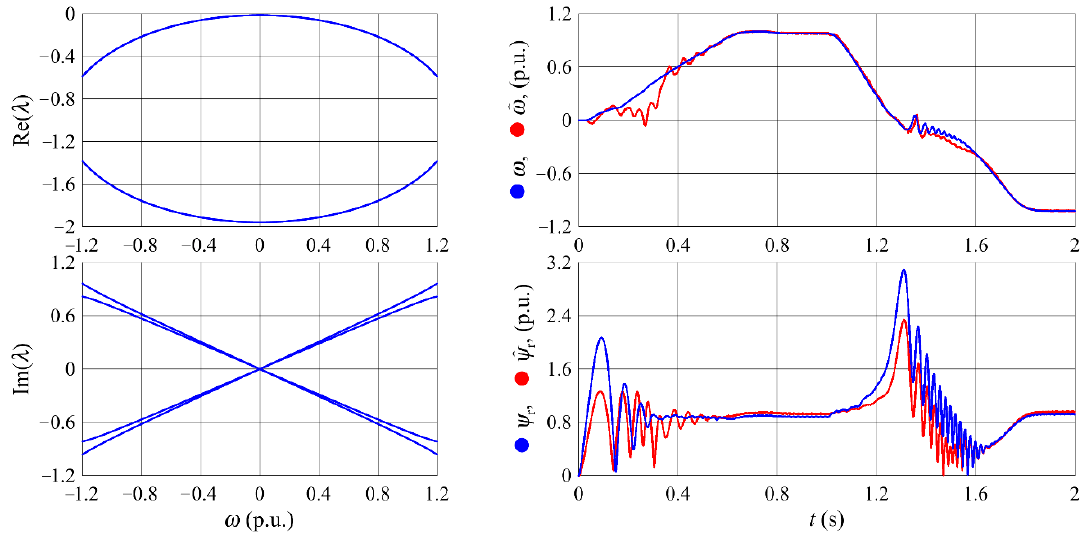
Figure 6. The eigenvalues and simulation results obtained for the proportional observer.